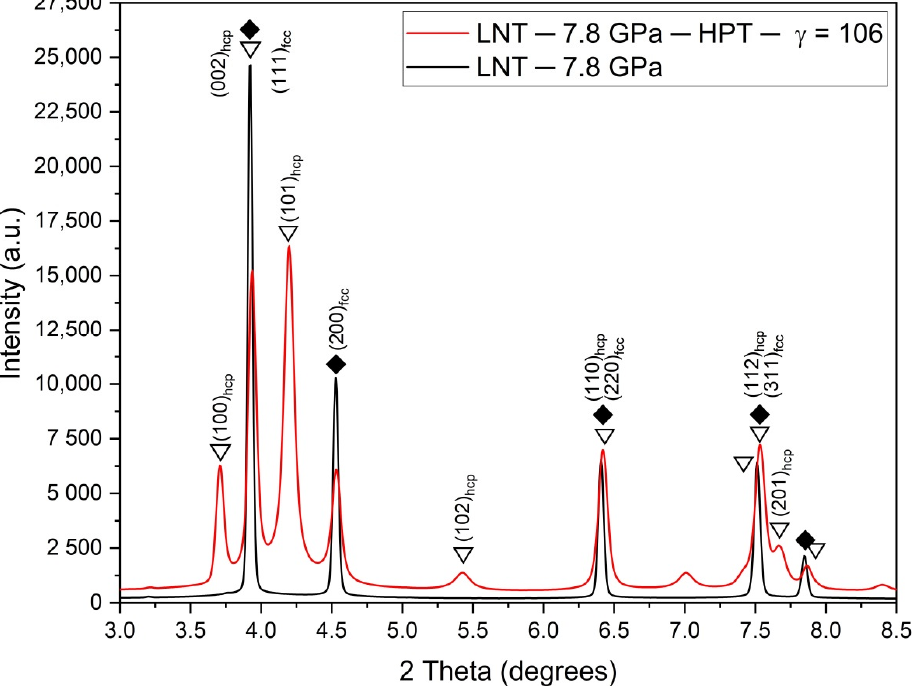
Figure 5. X-ray diffractograms after HPT at LNT clearly showing the necessity of shearing for in- ducing the phase transformation up to pressures of 7.8 GPa. inducing the phase transformation up to pressures of 7.8